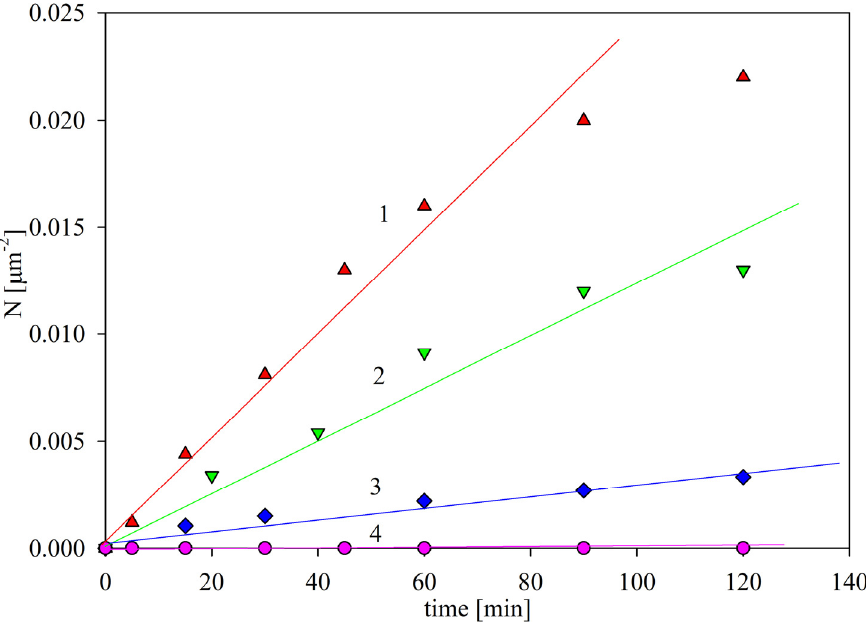
Figure 7. The kinetics of SAL immunolatex particle deposition at PAH-modified mica under convection conditions (OBIJ microfluidic cell ) shown as the dependence of the surface concentration on the deposition time; particle bulk concentration 100 mg L − 1 , 1 mM NaCl; flow rate 2.5 × 10 − 3 cm 3 s − 1 . The points show the results obtained for: 1. ( ▲ ) pH 9–7.4; 2. ( ▼ ) pH 7; 3. ( ♦ ) pH 6; 4. ( ● ) pH 5 − 3.5. The solid lines are linear fits of the experimental data.